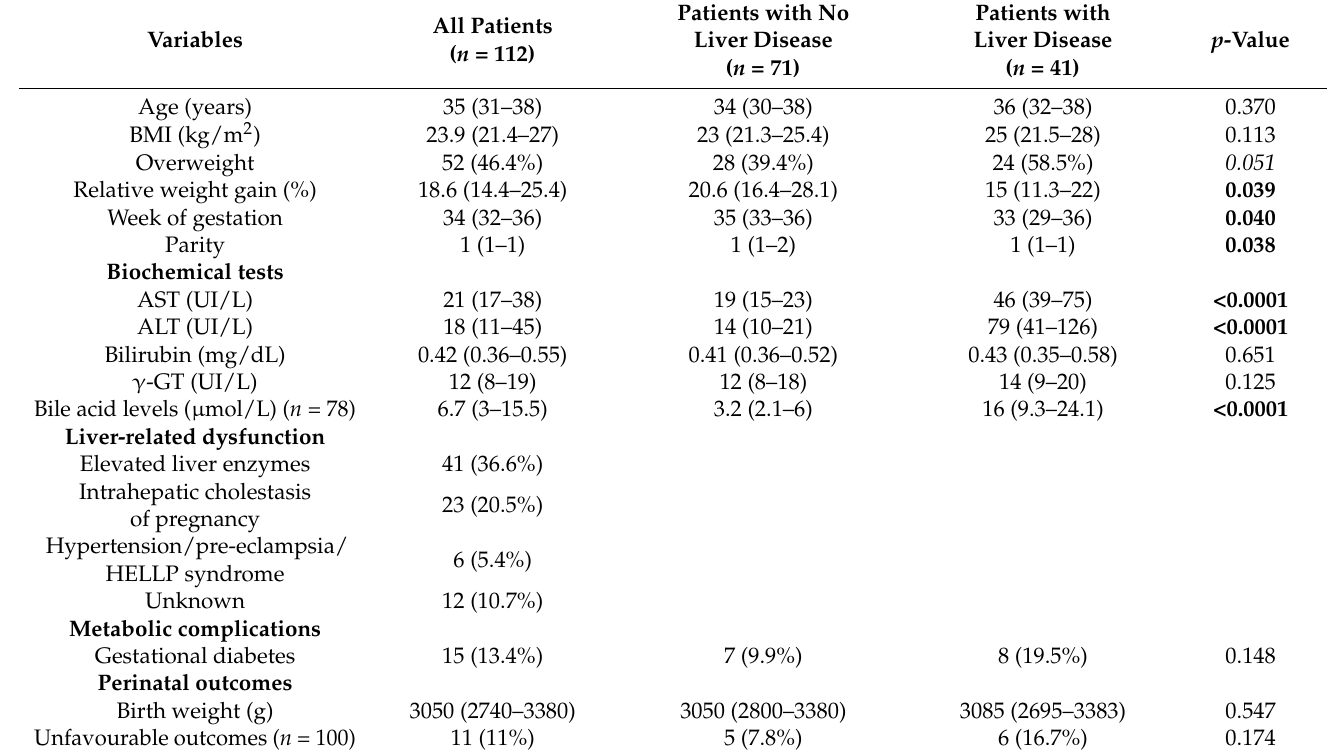
Table 1. Characteristics of the patients included in the study.